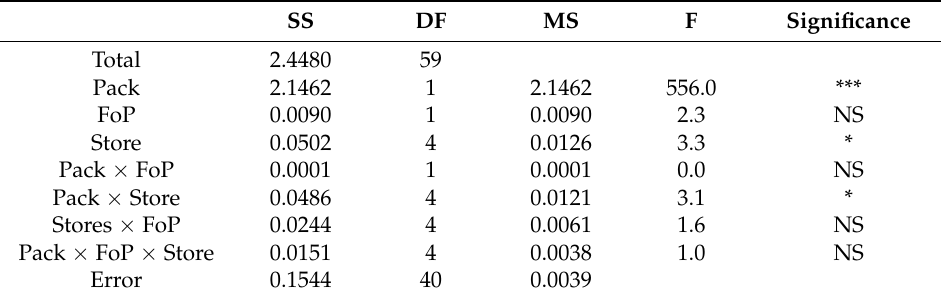
Table 2. Analysis of variance Dunedin, stores as third independent variable.